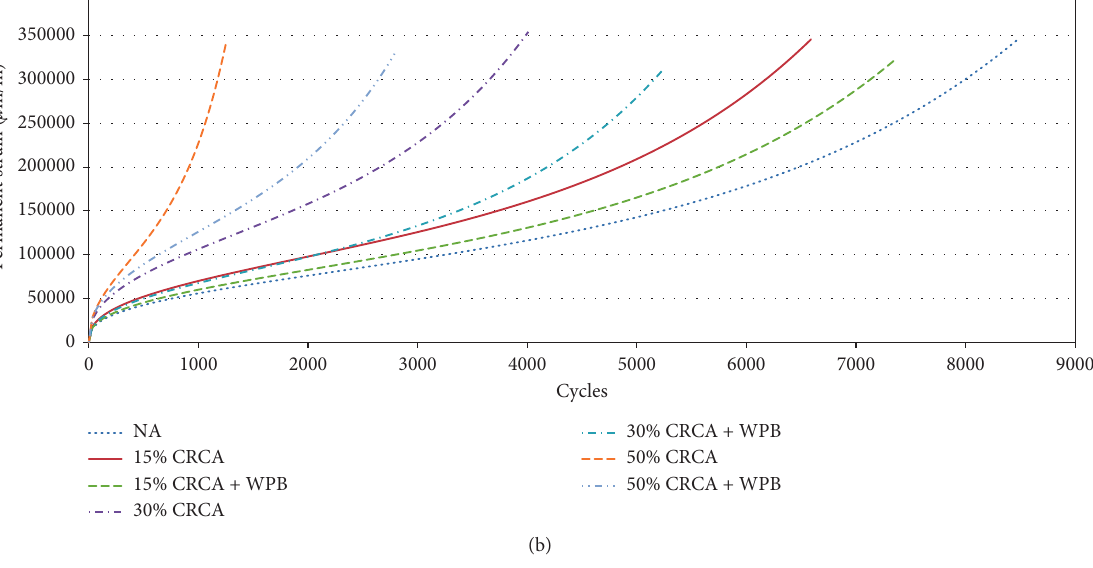
Figure 5: Permanent strain versus the number of loading cycles at testing temperatures (a) 40 ° C and (b) 60 ° C.